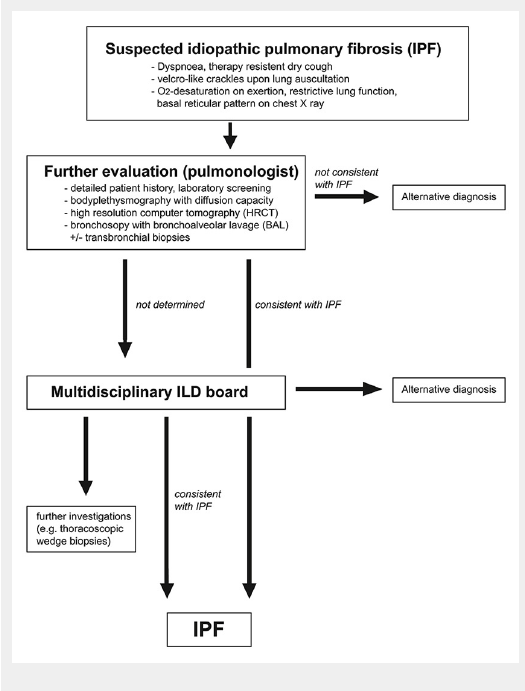
Diagnostic algorithm for suspected idiopathic pulmonary fibrosis. In the case of suspicion the patient is evaluated by an experienced pulmonologist. High-resolution computed tomography and bronchoalveolar lavage are performed. If the diagnosis is not clear the patients are discussed at a multidisciplinary interstitial lung disease (ILD) board and further diagnostic steps are taken if indicated (modified from